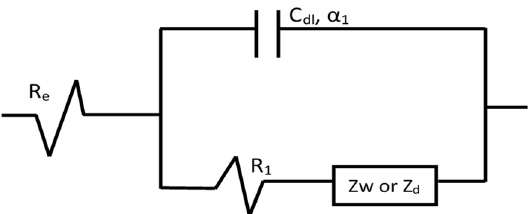
Figure 14. Electrical equivalent circuit used for the fitting of EIS experimental data. Z w was employed in the first 70 h for the B samples and the first 100 h for the BR samples. Z d was employed for longer immersion times.